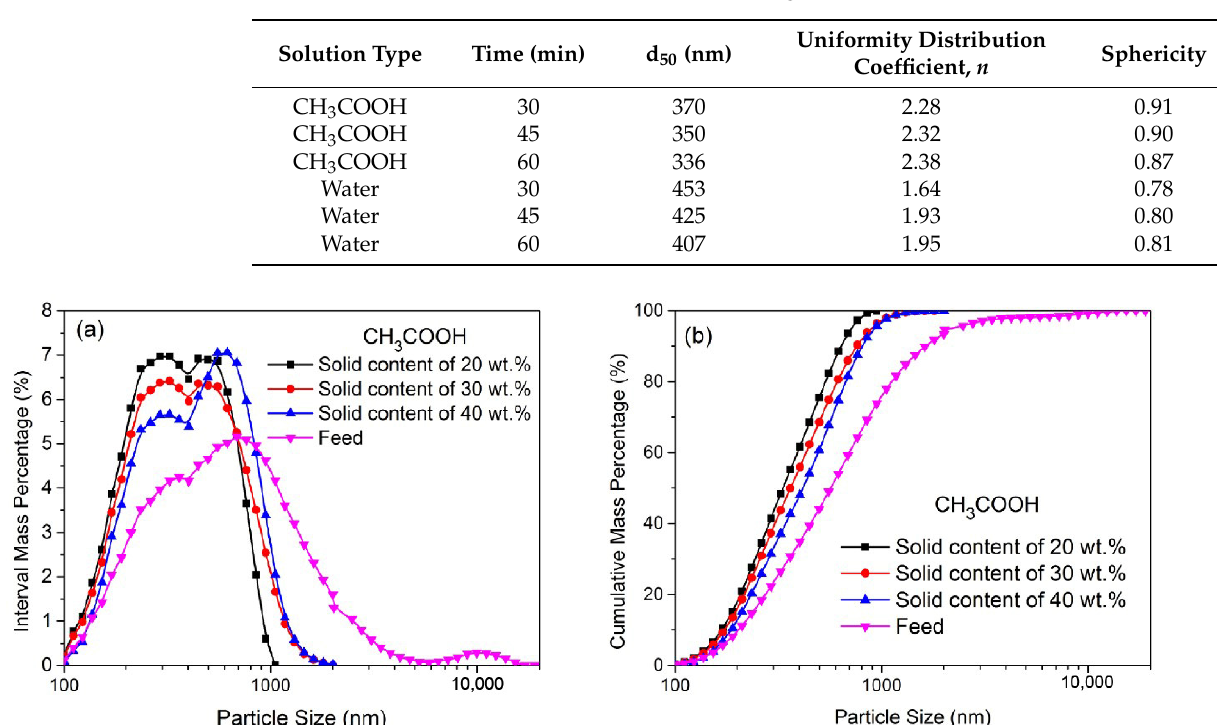
Table 4. The d 50 , n and sphericity values of ZnO particles ground in water or in a CH 3 COOH solution at a low concentration of 0.010 mol/L for different lengths of time.